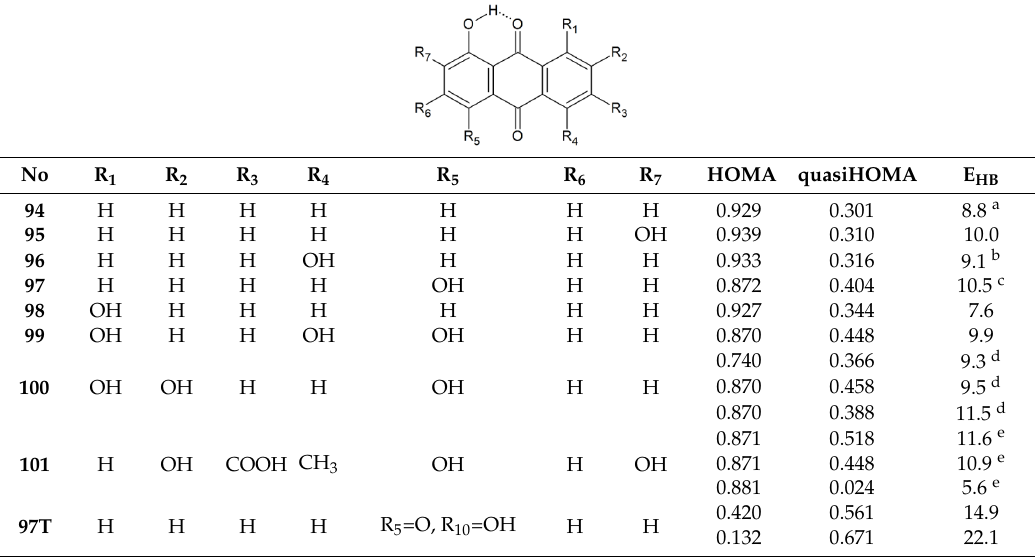
Figure 3. The transfer of aromaticity from ipso -ring to the enolic system in naphthazarin. Values of quasiHOMA (in blue) and E HB (in red) were given in the centre of the hydrogen bonded ring, whereas the HOMA value was given in the ipso -ring. Table 3. HOMA and quasiHOMA indices and energy of hydrogen bond (kcal/mol) calculated for HB rings in substituted hydroxyanthraquinones.